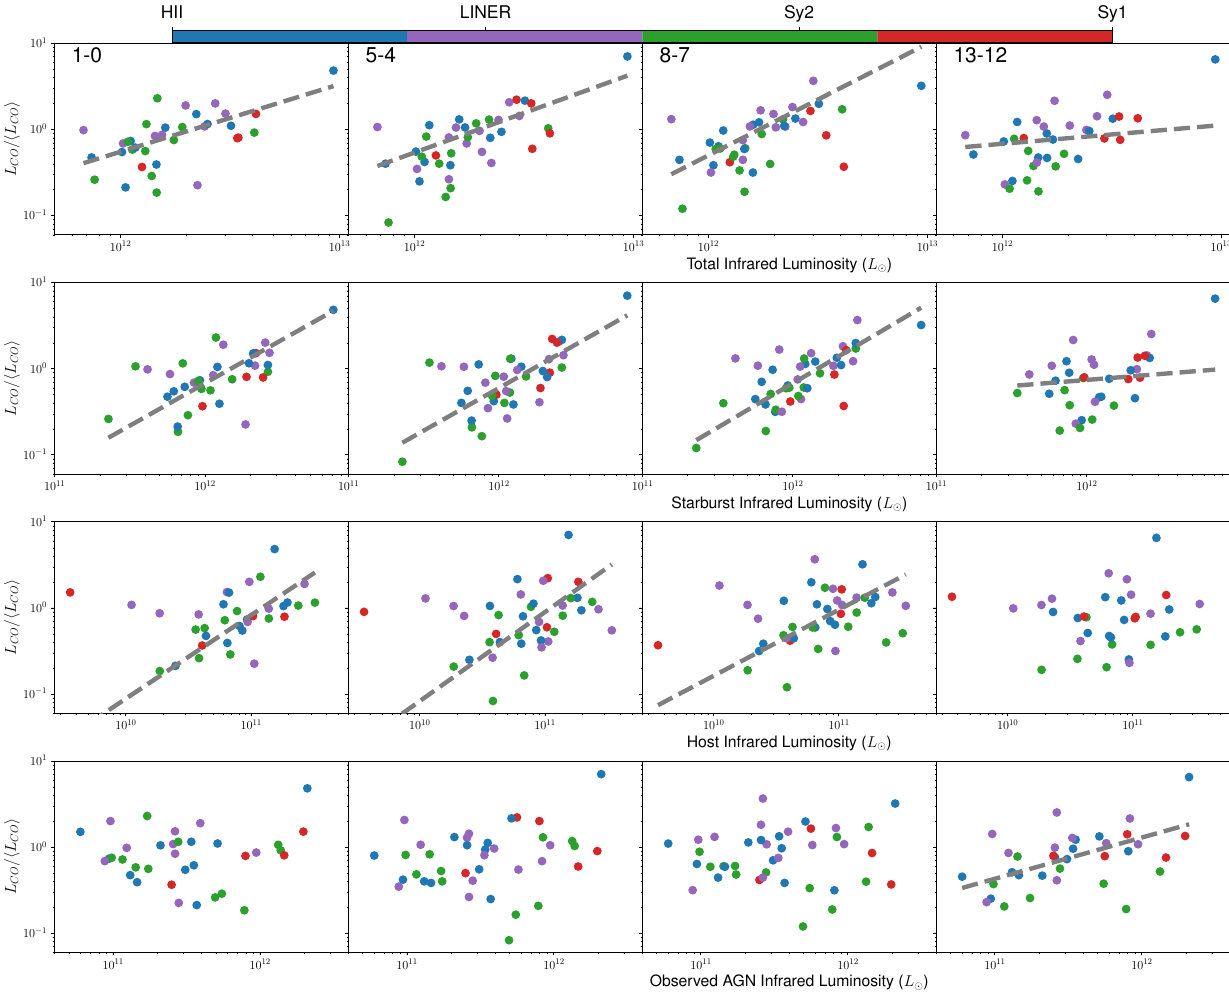
Figure 3. Example relations between CO line luminosities L CO (Table 1), normalized by the relevant L CO mean CO luminosity , and total, starburst, host, and observed AGN infrared luminosities (cid:104) (cid:105) (Sections 3.1 and 3.2). The best-fit relations are plotted, if there is evidence for a correlation. No strong dependence on optical spectral type is